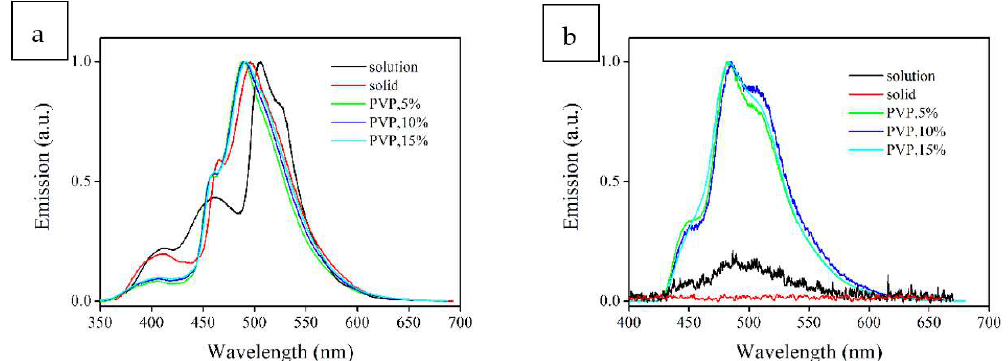
Figure 4. Emission spectra of Ir(ppy) 2 (BPE) ( a ) and Ir(ppy) 2 (TPP) ( b ) in CH 2 Cl 2 solution (1 μM), in the solid state and in PVP fiber (5%, 10% and 15%).